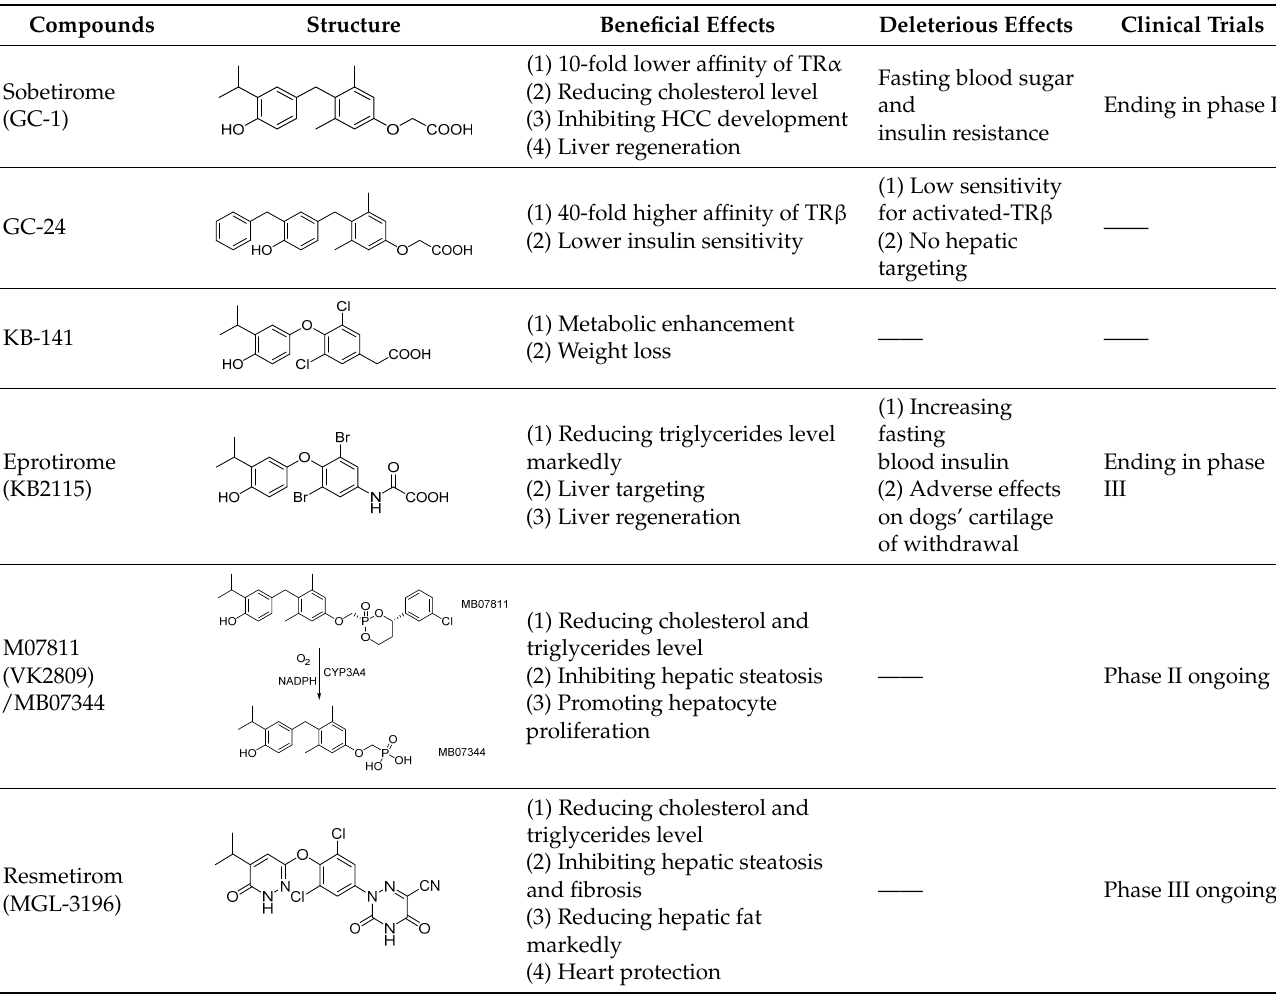
Table 1. Summary of synthetic thyromimetics.